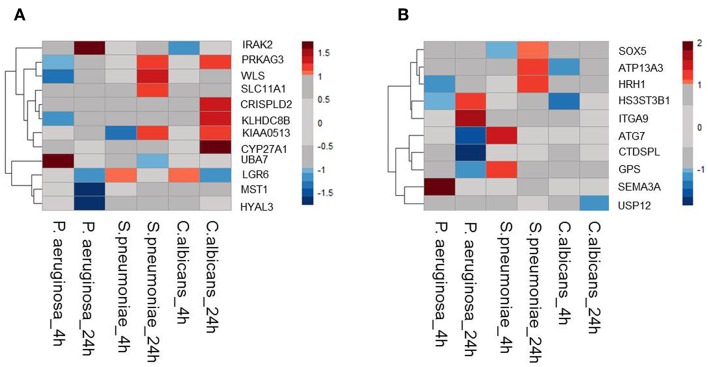
Expression QTL mapping and differential expression analyses prioritized potential genes. (A) Among 45eQTL genes, there are 12 genes that are differentially expressed in at least one condition in stimulated PBMCs. (B) Expression levels of cis genes that have not eQTL effect in blood, but differentially expressed upon stimulation in PBMC. Heatmap was plotted based on log2 (Fold-change) of RNA expression levels in P.aeruginosa, S.pneumoniae, and C.albicans-stimulated PBMCs. RNA expression levels were measured after 4 or 24 h of stimulation. Colors represent the RNA expression levels, red, significantly induced genes; blue, significantly suppressed genes; gray, not significantly different between stimulated and non-stimulated PBMCs.